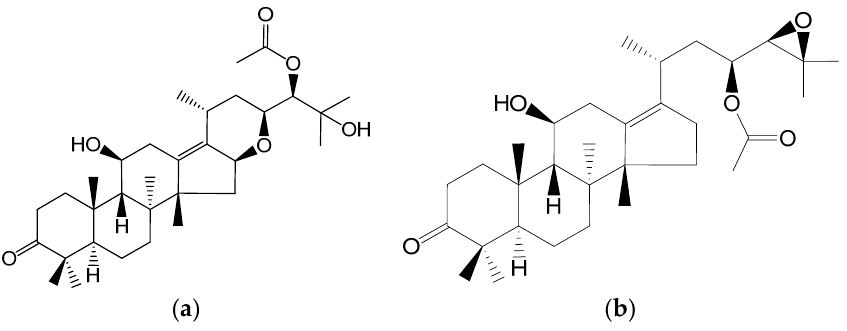
Figure 1. Chemical structures of alisol F 24-acetate ( a ) and alisol B 23-acetate ( b ).